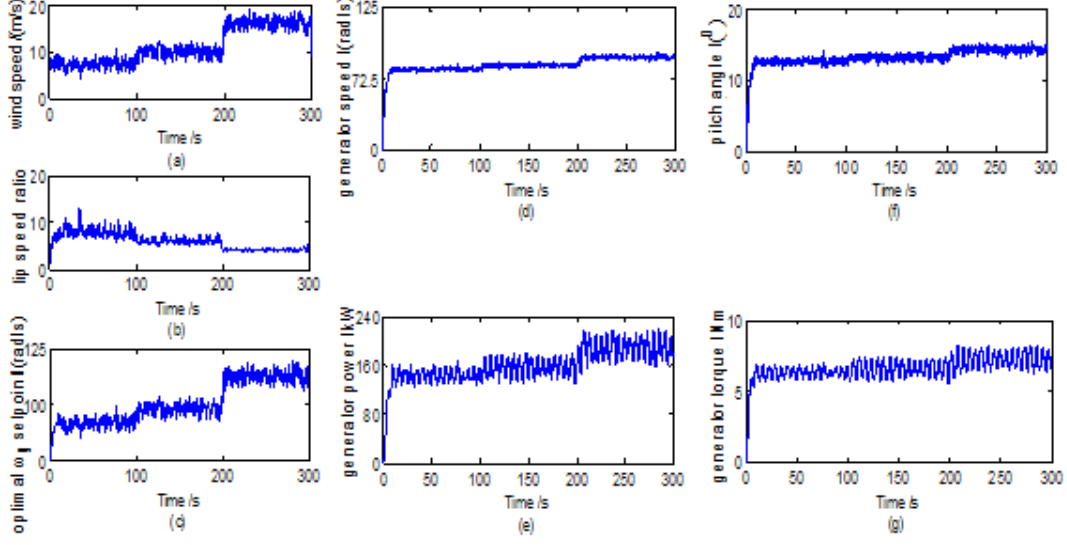
setpiont (rad/s); ( d ) generator speed (cid:3034)